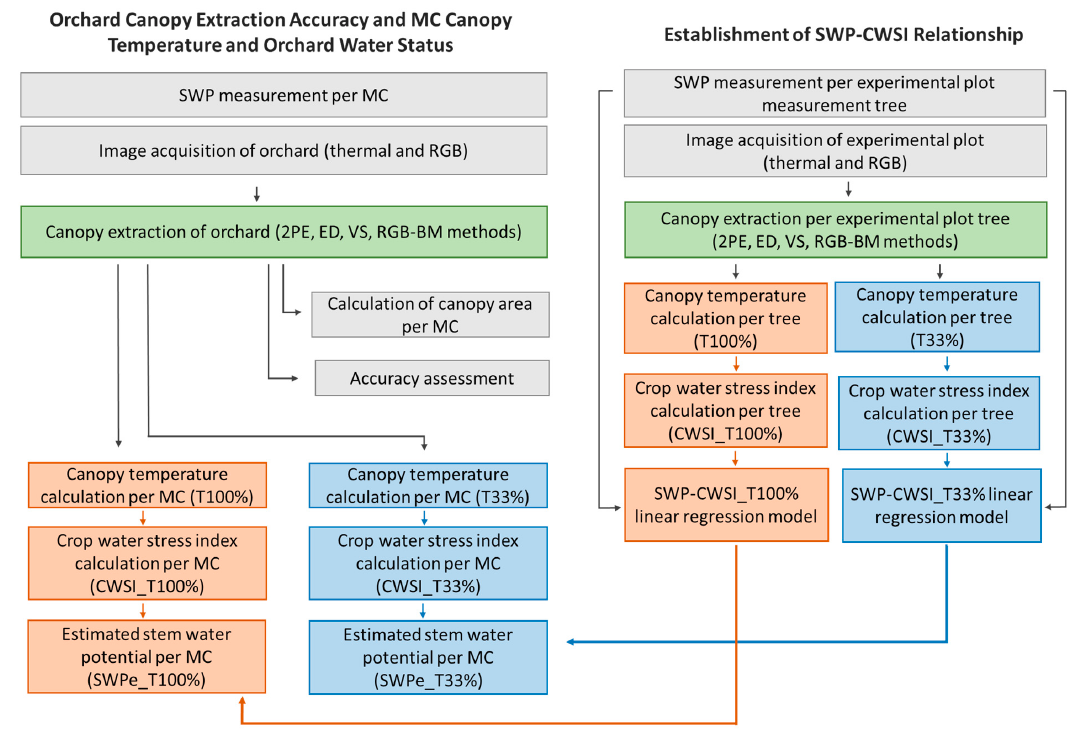
Figure 2. Data acquisition and analysis of orchard canopy extraction accuracy, canopy temperature, and orchard water status using the 2-pixel erosion (2PE), edge detection (ED), vegetation segmenta- tion (VS), and RGB binary masking (RGB-BM) canopy extraction methods (green boxes). Canopy temperature per management cell (MC) was calculated using the average of 100% of canopy pixels (T100%) (orange boxes) and the average of the coolest 33% of canopy pixels (T33%) (blue boxes). Orchard water status was estimated using the crop water stress index (CWSI) and the estimated stem water potential (SWPe). The SWPe was based on a tree-scale stem water potential (SWP) and CWSI relationship established using each canopy extraction method and each canopy temperature calculation